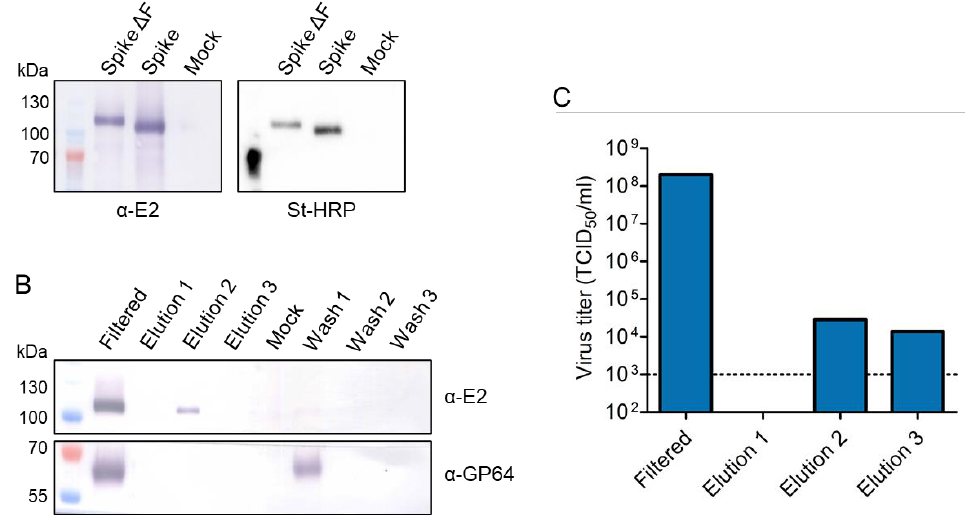
Figure 5. Strep-Tactin affinity column purification of Strep-tagged spikes. Sf21 cells were infected with Ac-Spike and Ac-Spike ΔF. Medium fractions were harvested, 0.2 μm filtered and purified using a Strep-Tactin affinity column. ( A ) Secreted proteins in the filtered medium fraction were analyzed on a CHIKV α-E2 Western blot and Strep-tag-conjugated St-HRP Western blot. ( B ) Secreted proteins in the filtered medium, and Strep-Tactin wash and elution fractions were analyzed on a CHIKV α-E2 Western blot and baculovirus α-GP64 Western blot. ( C ) Baculovirus titers in the filtered medium and Strep-Tactin elution fractions were determined by end-point dilution assay (threshold indicated by dotted line).